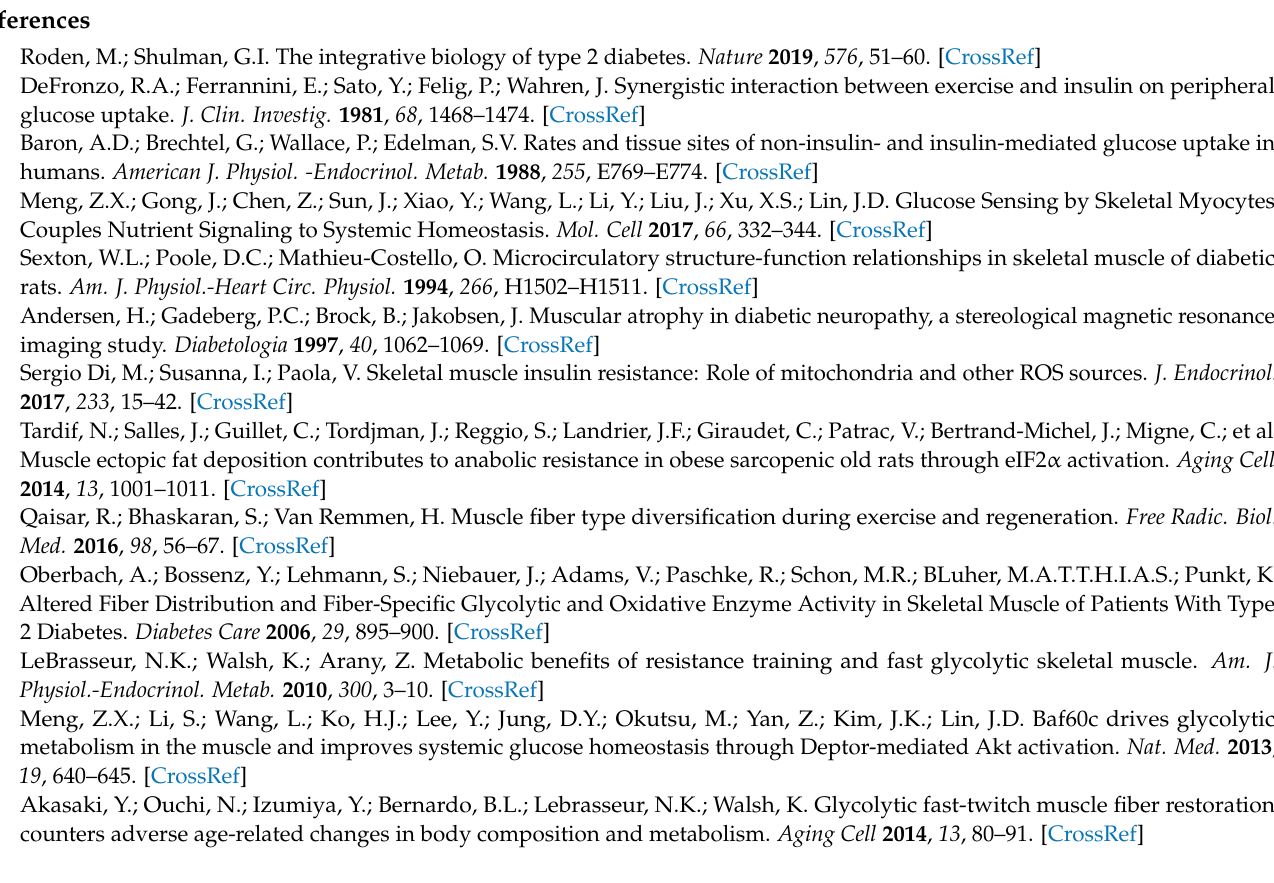
Table S1: Diet compositions; Table S2: Primer sequence; Table S3: Primary